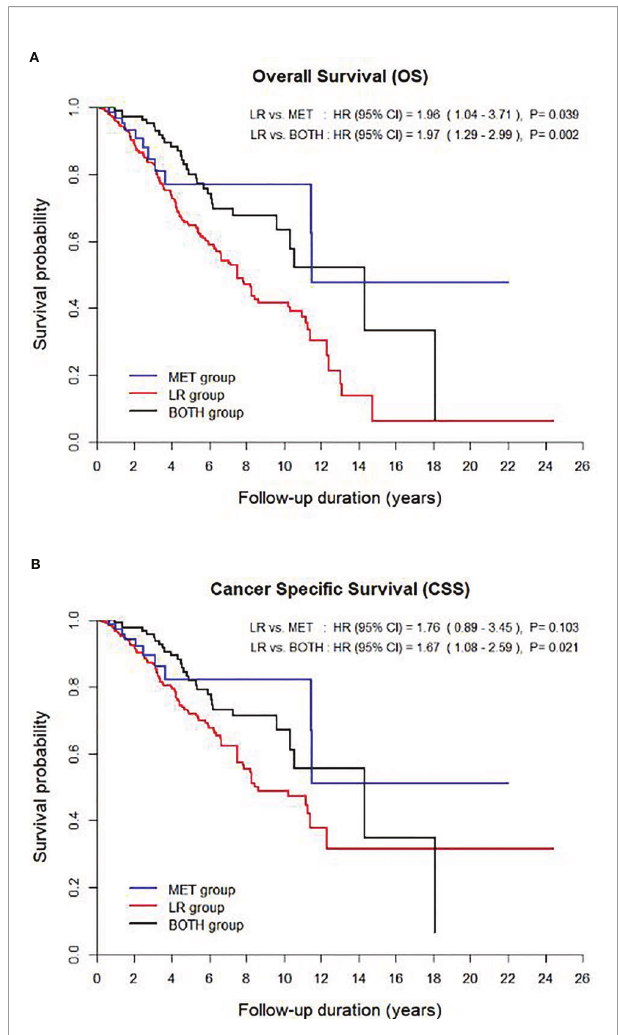
FIGURE 1 | Survival curves of the multivariable model for (A) overall survival and (B) cancer-speci fi c survival among the three groups. CI, con fi dence